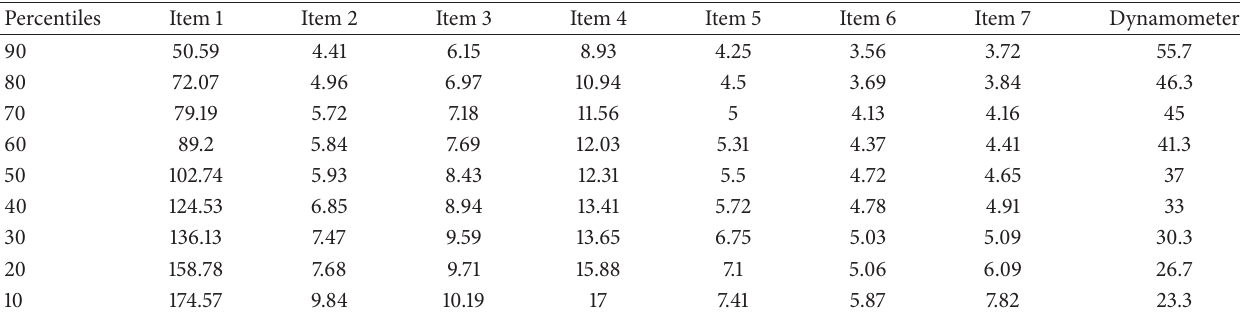
Table 10: 𝑛 = 19 , females, 20–94, nondominant hand, educational instruction: elementary school.